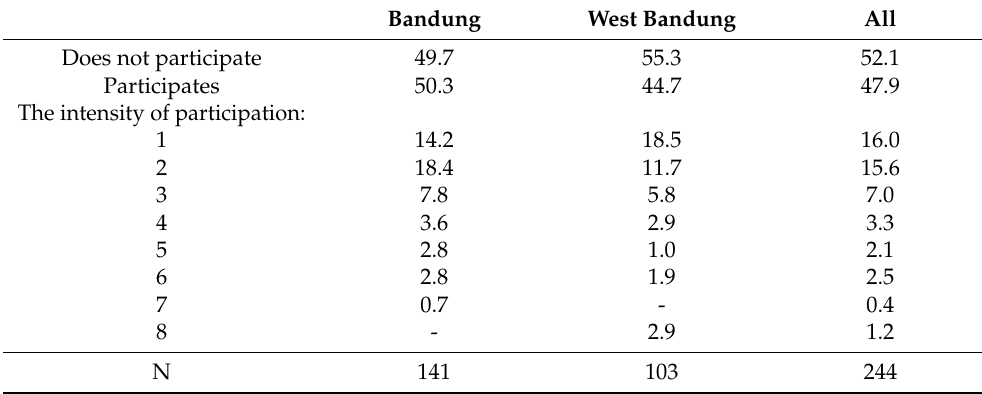
Table 4. Distribution of farmers by their participation in conservation (%). Bandung West